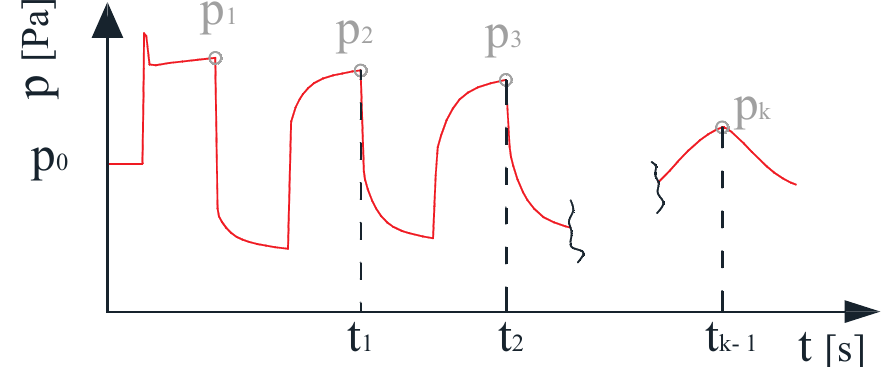
Figure 5. Pressure overshoot at the first bulk pressure amplitude.